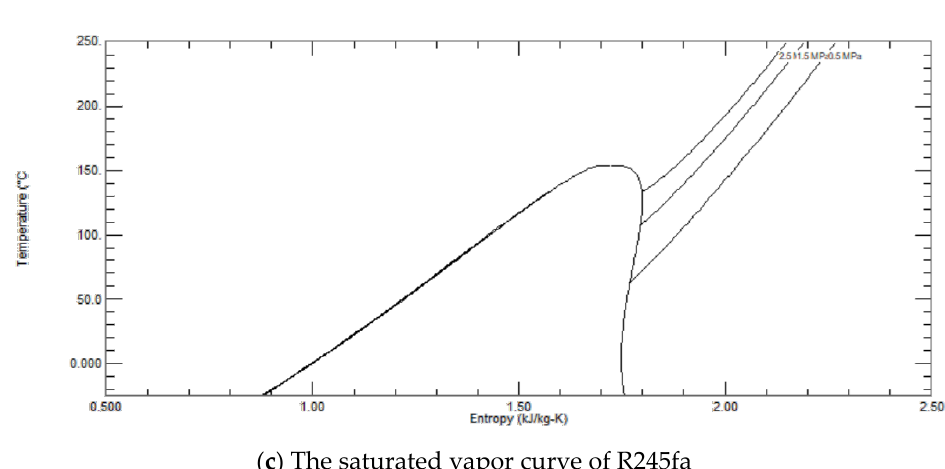
Figure 5. Saturated vapor curves of dry, wet, and isentropic working fluids.